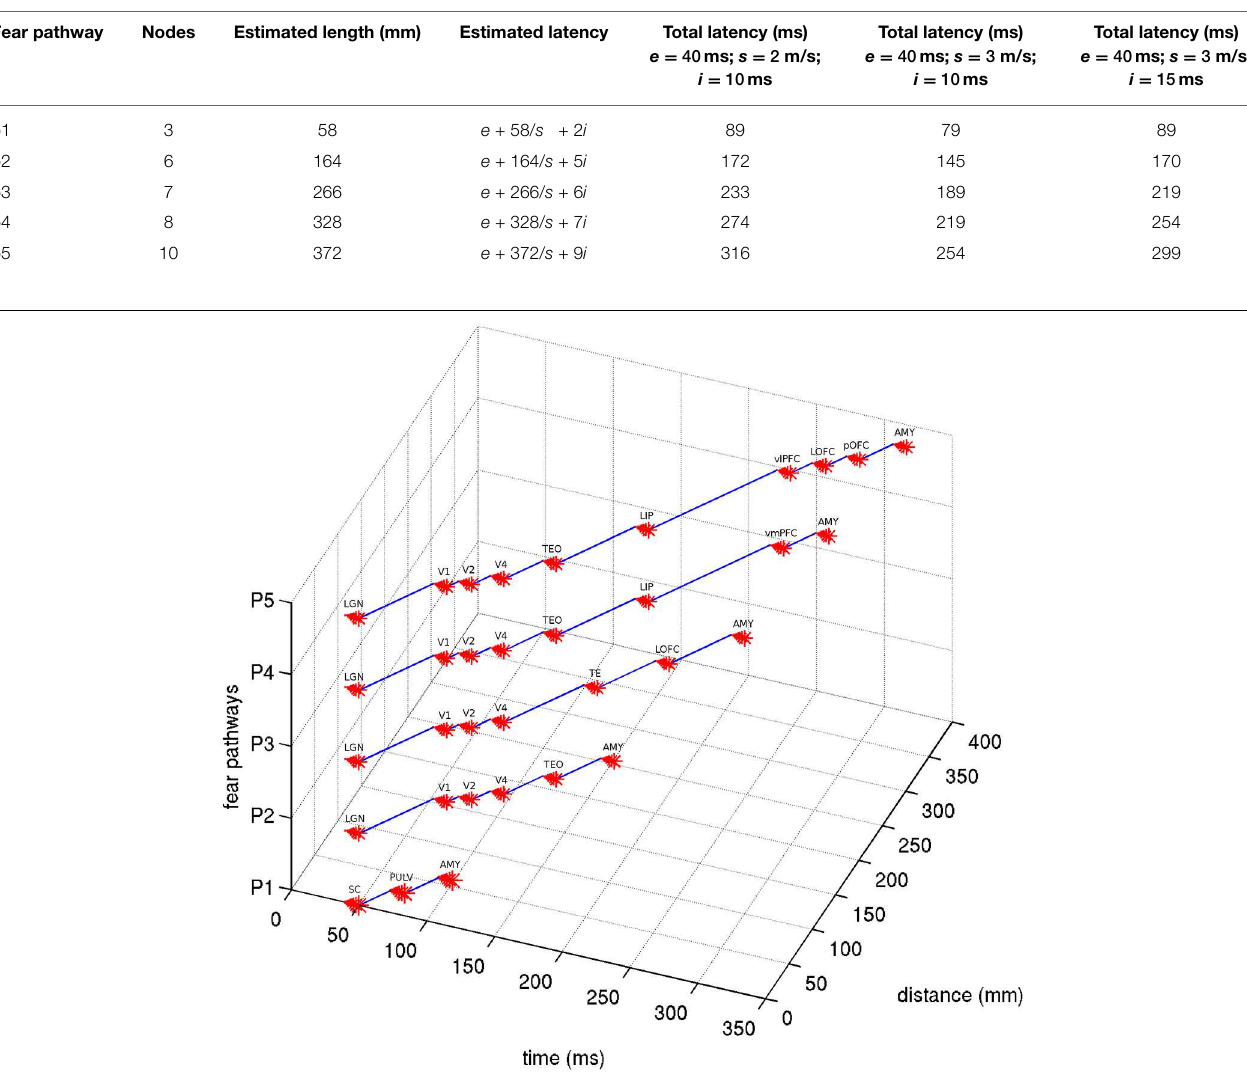
FIGURE 4 | Latency estimates of the five visual fear signaling pathways. Assumes a latency of 40ms from retina to LGN/SC, synaptic integration time of 10ms at each ROI node and a propagation speed of 2 m/s. Abbreviations are described in Table 1